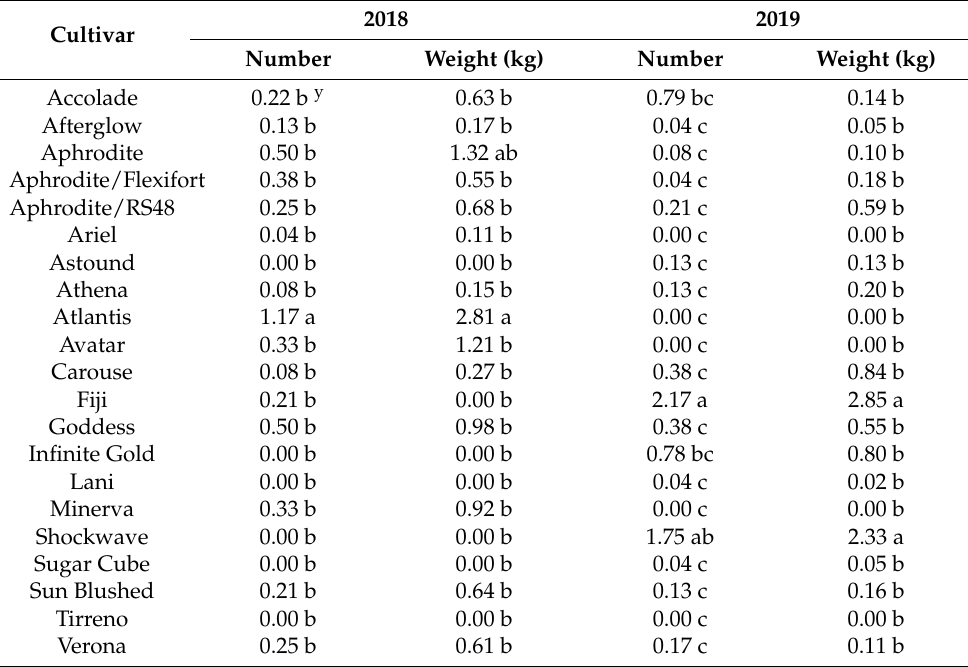
z Values are the mean of four replications; data were analyzed using the mixed procedure and means were separated using PDIFF; values followed by different letters within a column are significantly different at P < 0.05; “Aphrodite” was considered the standard. y Experimental units consisted of six